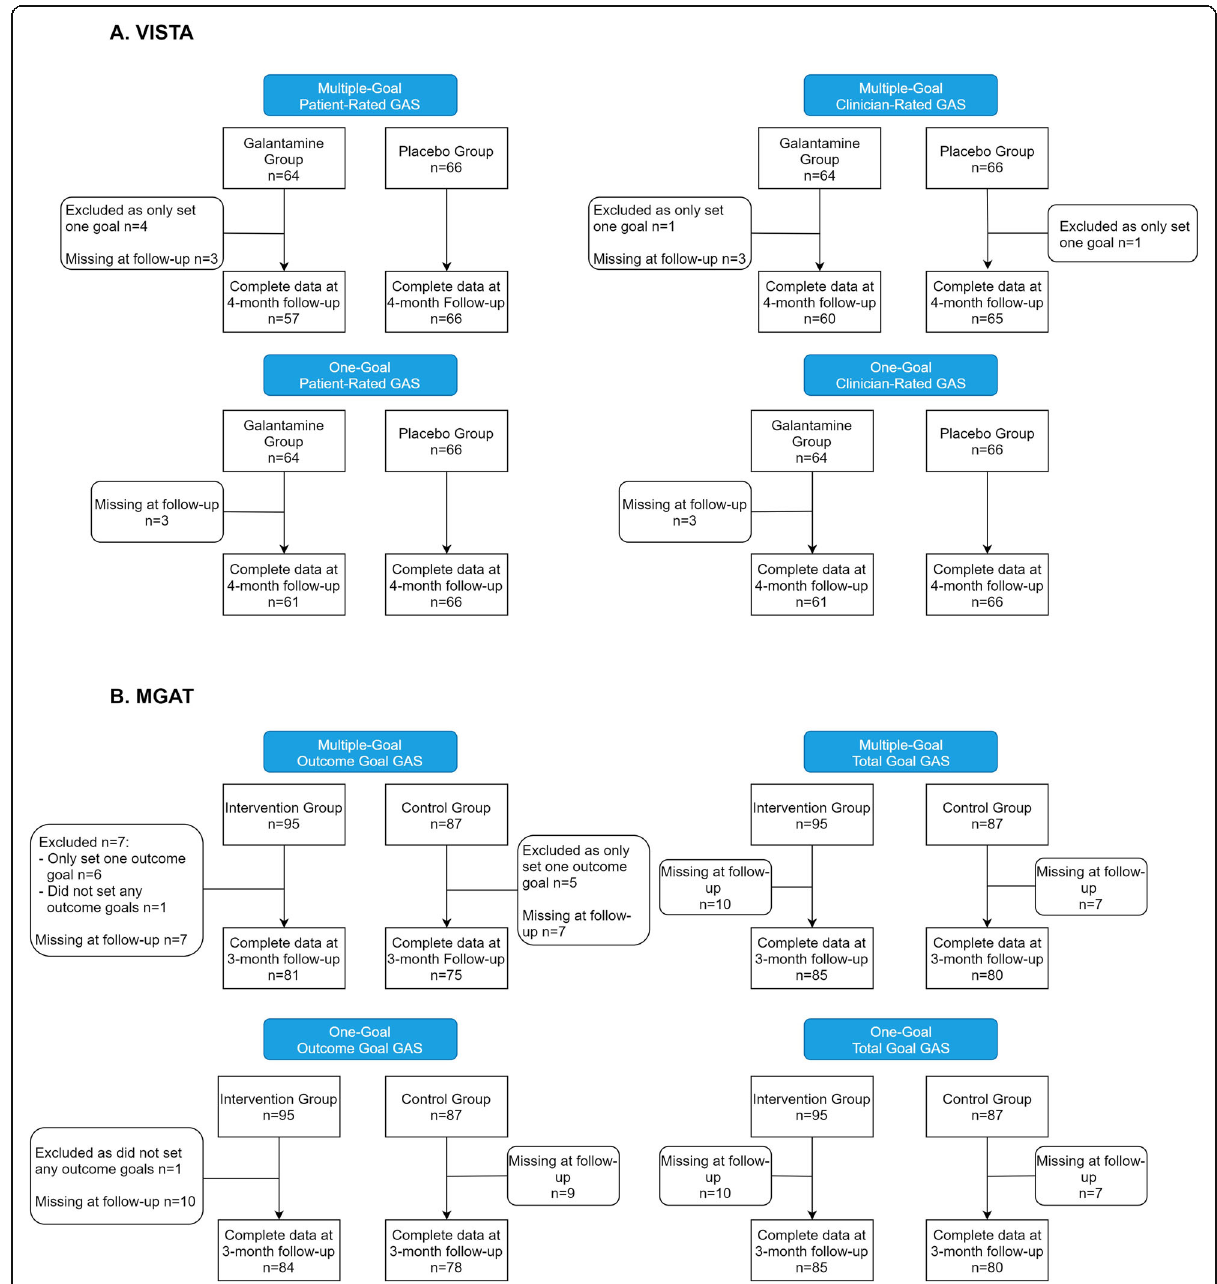
Fig. 1 Flow chart of VISTA and MGAT subjects included in multiple- and one-goal GAS analyses. In VISTA, analyses were conducted on patient- rated GAS scores and clinician-rated GAS scores. In MGAT, analyses were conducted on outcome goal scores (goals directed towards outcomes of care) and total goal scores (goals directed towards outcomes, but also those focused on prevention or the completion of a particular process, which may be easier to